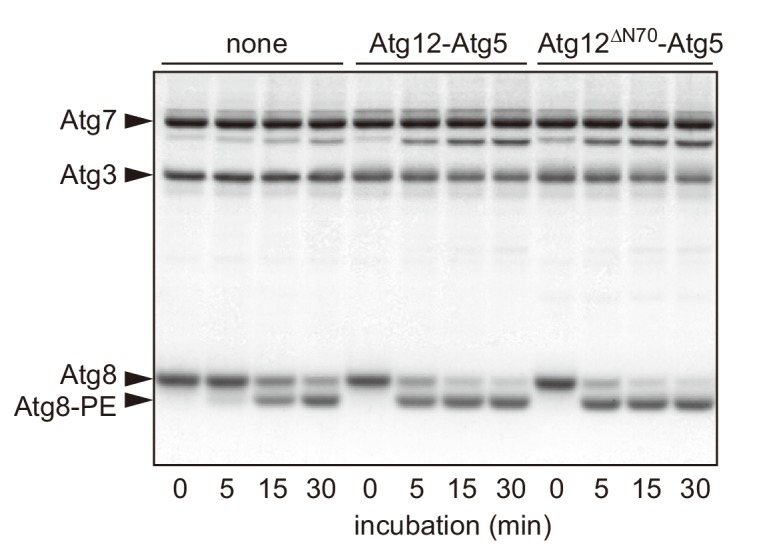
The N-terminal region of Atg12 is not required for the E3 activity of the Atg12-Atg5 conjugate.Recombinant proteins and liposomes (20 mol% DOPE, 70 mol% POPC, and 10 mol% yeast PI) were prepared as described previously (Nakatogawa et al., 2007; Sakoh-Nakatogawa et al., 2013). Atg8 (5 μM), Atg7 (1 μM), Atg3 (1 μM), ATP (1 mM), and liposomes (350 μM lipids) were incubated with wild-type Atg12-Atg5 or Atg12ΔN70-Atg5 (0.2 μM) at 30°C for the indicated time periods, and analyzed by urea-SDS-PAGE and subsequent CBB staining. Protein bands of Atg12-Atg5 are not visible in this analysis due to its low concentration.